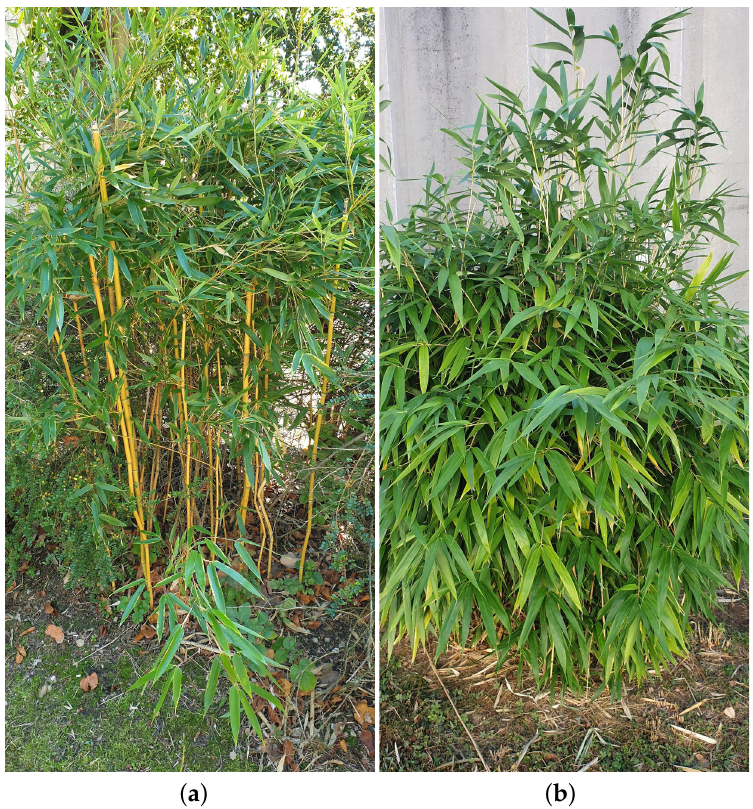
Figure 1. Photographs of the bamboo varieties studied: ( a ) Phyllostachys Aureosulcata, ( b ) Sasa